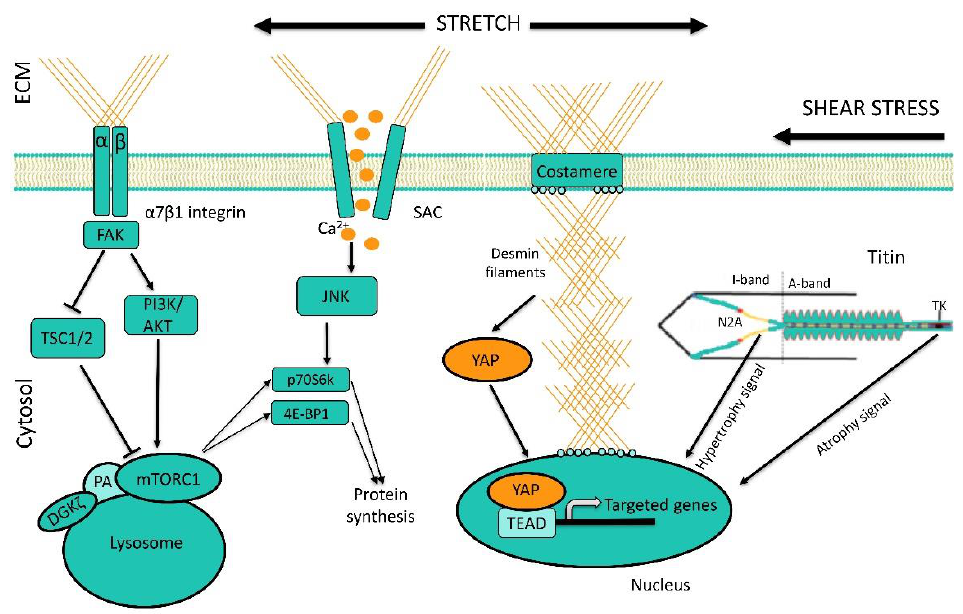
Figure 6. Mechanosensory structures in the muscle fiber. Mechanical factors a ff ect the muscle fiber through a resistive load (the active factor of which is stretching, i.e., an increase in the fiber length relative to its average or minimum length) as well as shear stress, i.e., through the interaction of the fiber with external structures, which move relative to its surface. Integrin molecules, embedded in the sarcolemma, interact with the fibrillar components of the extracellular matrix (ECM) and, when shifted (changing the angle of inclination relative to the membrane), transmit a signal to the focal adhesion kinase (FAK), which, through AKT phosphorylation or TSC2 inhibition, stimulates mTORC1 activity and, consequently, protein synthesis. A change in the fiber can lead to the opening of stretch-activated or mechano-stimulated cation channels allowing for Ca 2 + influx, and subsequent activation of calcium-dependent kinases transmitting a signal towards ribosomal kinases. An important component of mechanotransduction is the interaction of cytoskeletal molecules (for example, desmin) with Yes-associated protein (YAP), which can translocate to the myonucleus and, interacting with transcription factor TEAD, regulate the expression of a number of key genes. Under mechanical perturbation (shortening or lengthening of the fiber), the giant protein of the sarcomeric cytoskeleton titin releases titin-linked signaling molecules (MuRF-1 and 2, muscle ankyrin repeat protein), which are translocated into the myonucleus and participate in the regulation of gene expression.